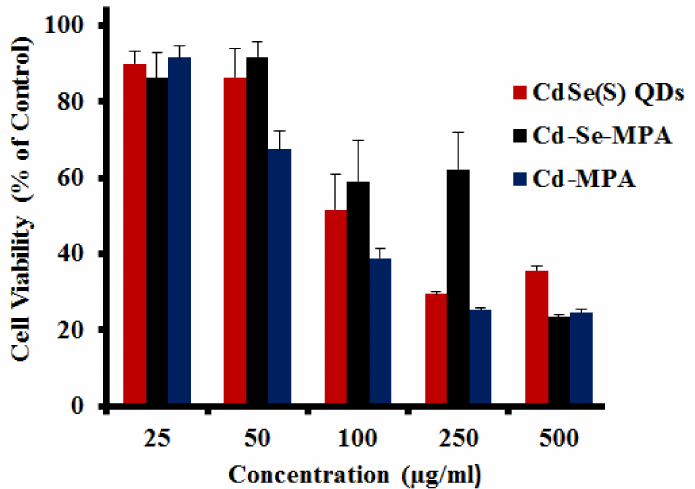
Figure 5. The results of cytotoxicity assays of CdSe(S) QDs, Cd-MPA, and Cd-Se-MPA precursors towards human colorectal carcinoma cells (HCT-116). Error bars indicate standard error of the mean and cell media without treatment with QDs was used as a